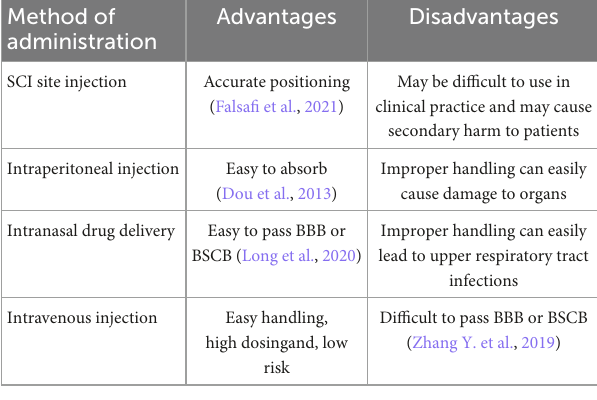
TABLE 2 Advantages and disadvantages of drug delivery